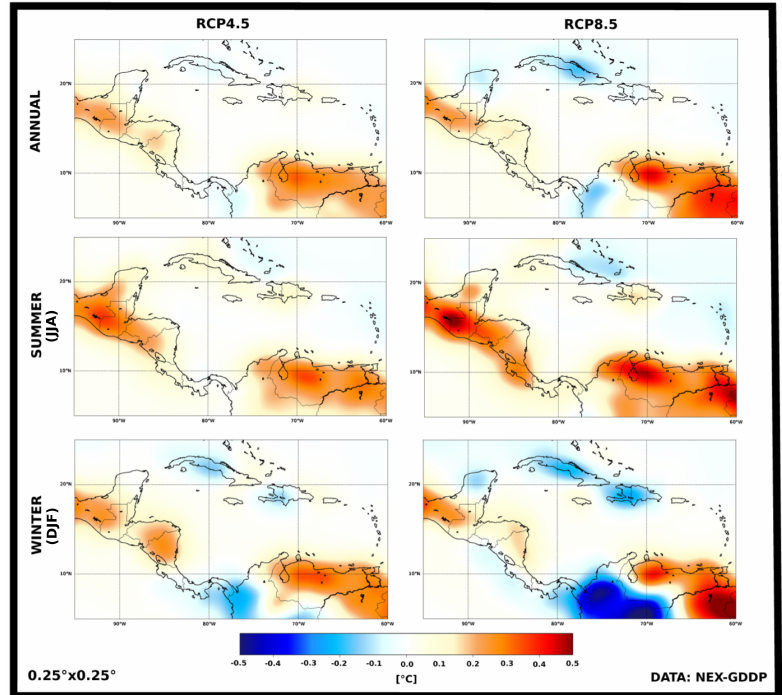
Figure 5. CMIP5 Multimodel Ensemble Mean change in DTR ( ◦ C) for 2070–2099 minus 1970–1999 for RCP 4.5 and 8.5